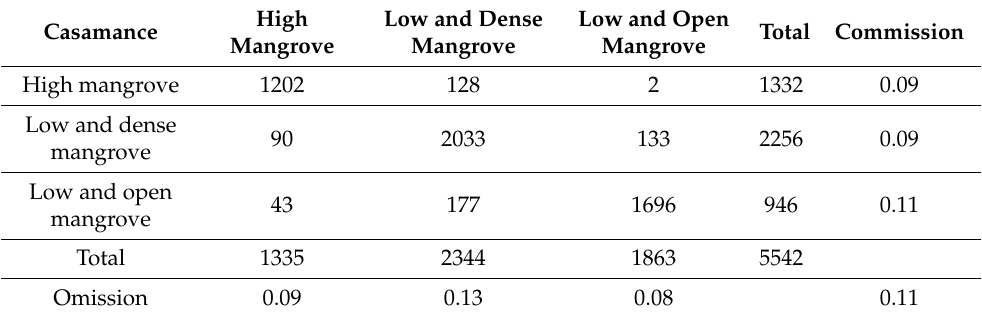
Table 4. Confusion matrix for the mangrove zonation classification in Casamance (ground truth in the rows, and categorical images in the columns).